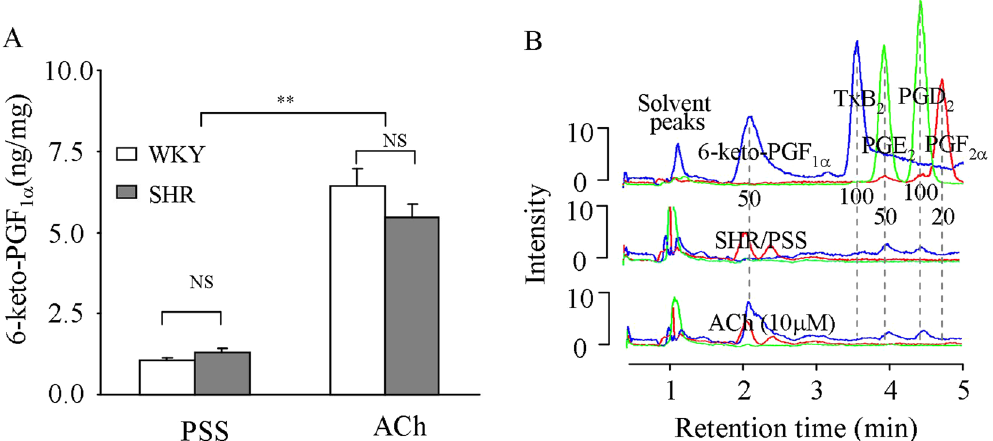
Figure 4. ACh-evoked production of 6-keto-PGF 1 α in rat mesenteric resistance arteries. ( A ) production of 6-keto-PGF 1 α measured with EIA in WKY and SHR vessels under the basal (un-stimulated in PSS) and ACh- stimulated conditions. N = 7 for each; ** P < 0.01; NS: not significant. ( B ) HPLC-MS showing peaks of 6-keto- PGF 1 α and other products in basal (middle) or ACh-stimulated SHR vessels (bottom). The top shows peaks obtained with solution of mixed standard compounds with amount indicated